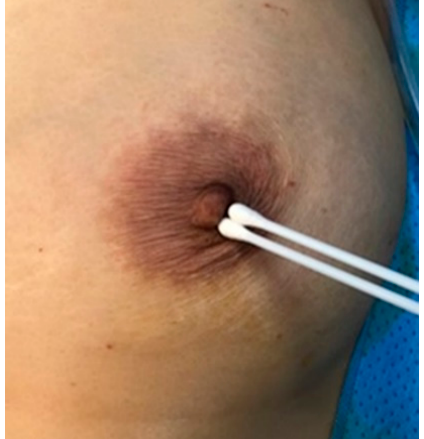
Figure 1. Endogenous flora specimen collection of nipple with cotton swab